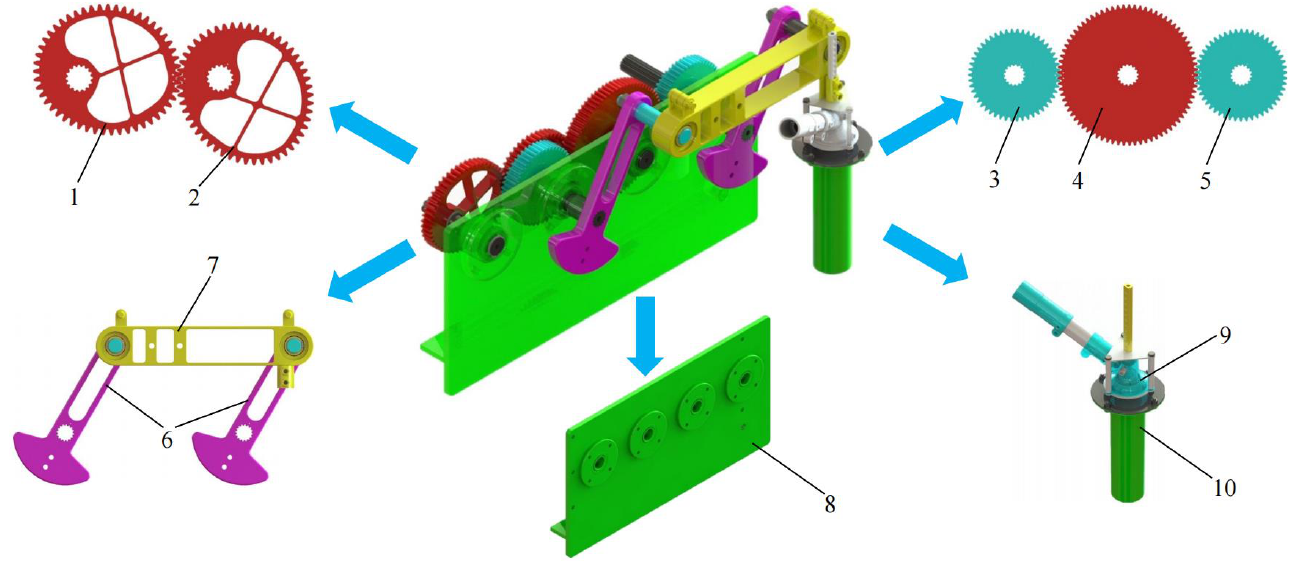
Figure 1. Structural diagram for the well-cellar cavitating mechanism: 1. non-circular gear 1; 2. non-circular gear 2; 3. spur gear 3; 4. spur gear 4; 5. spur gear 5; 6. crank; 7. linkage; 8. frame; 9. cavitating device; 10. cavitator.